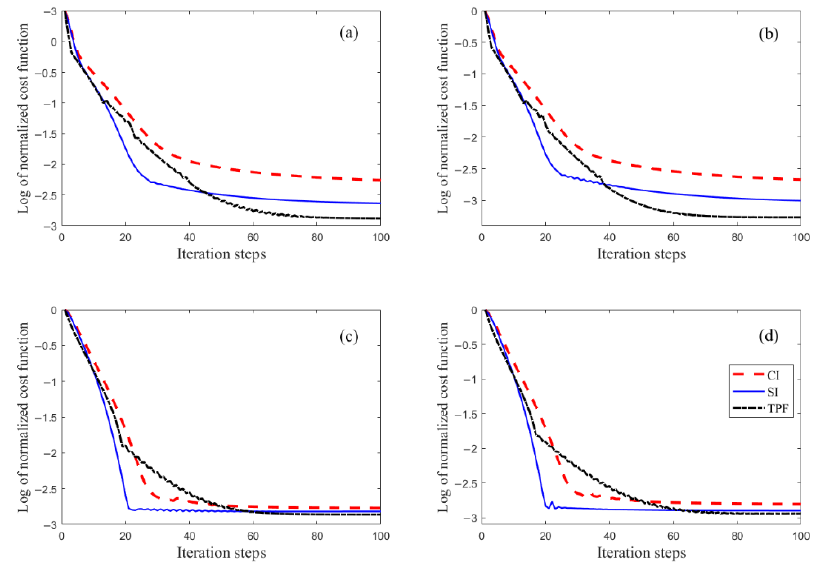
Figure 6. The descent process with iteration steps for the normalized cost function in log form of TE-1 ( a ), TE-2 ( b ), TE-3 ( c ) and TE-4 ( d ). Table 1. RMS errors and correlation coefficients of TE